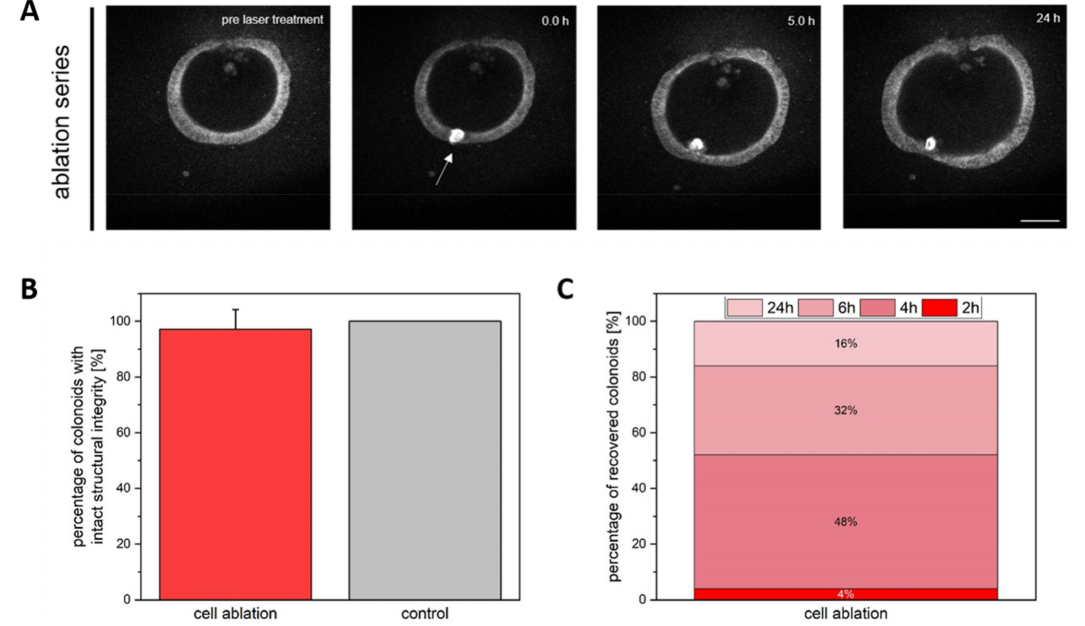
Figure 3. Influence of single cell ablation on the structural integrity of the colonoids. ( A ) A representa- tive time series of cell ablation. Ablation initially leads to strong autofluorescence in the manipulated region. Subsequently, an invagination of the ablated cells occurred and the cell layer closed over time. ( B ) 97.6% of damaged colonoids survived single cell ablation ( n = 125, SD). In the control group ( n = 64, SD), the survival rate was 100%. ( C ) The stacked bar chart indicates the percentage of recovered colonoids in defined time intervals. Scale bar 50 µ